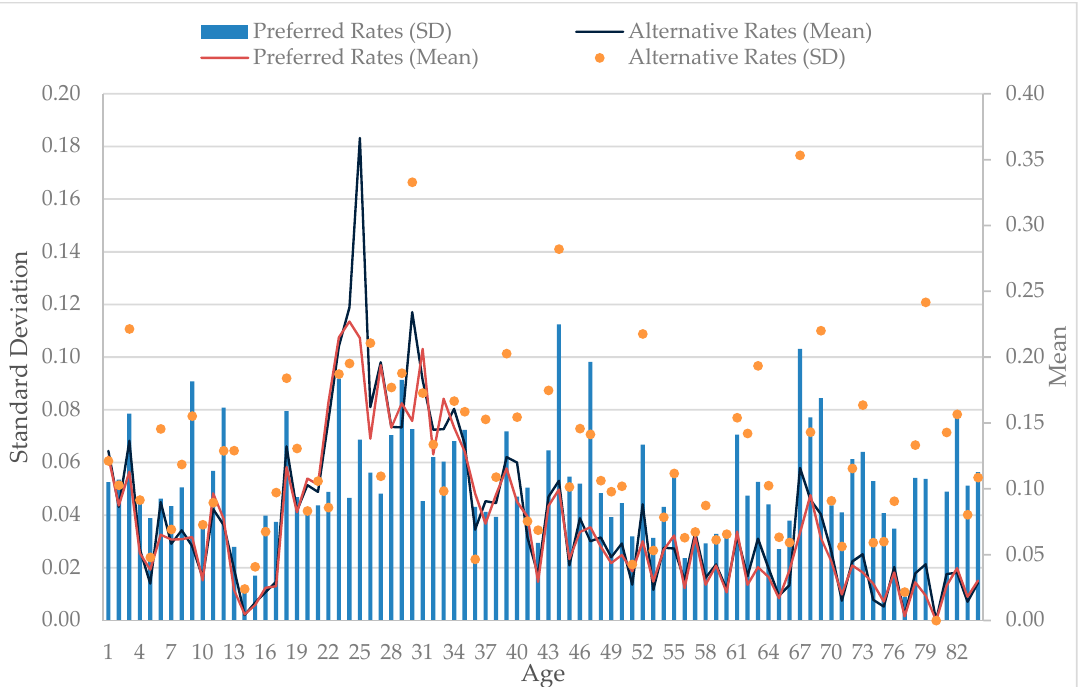
Figure 1 . Means and Standard Deviations of Male Domestic Out-Migration Rates, 2007–2014. Source: 2006–2014 1-Year American Community Survey.